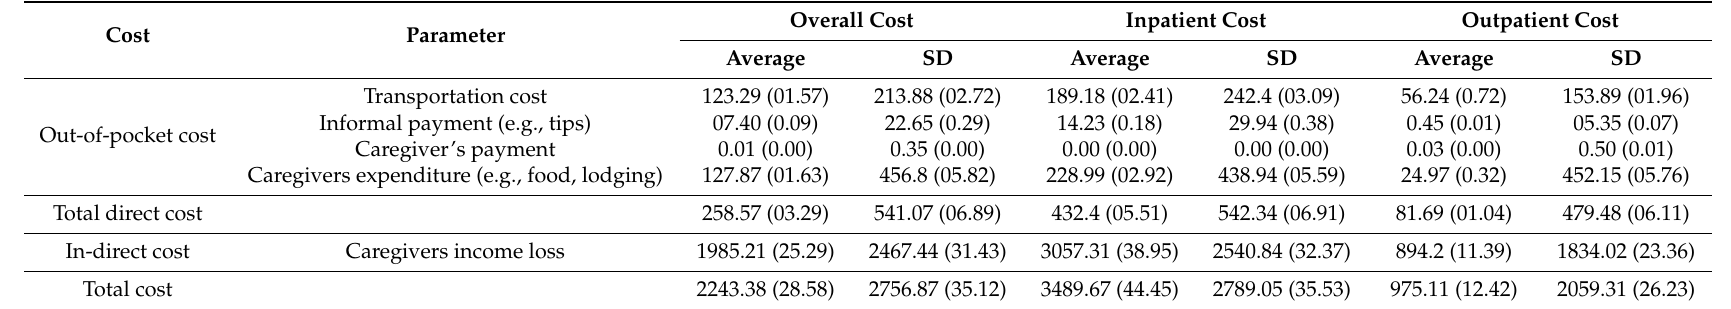
Table 2. Distribution of average caregivers’ cost of diarrheal treatment for tertiary level hospital ( N = 801) BDT